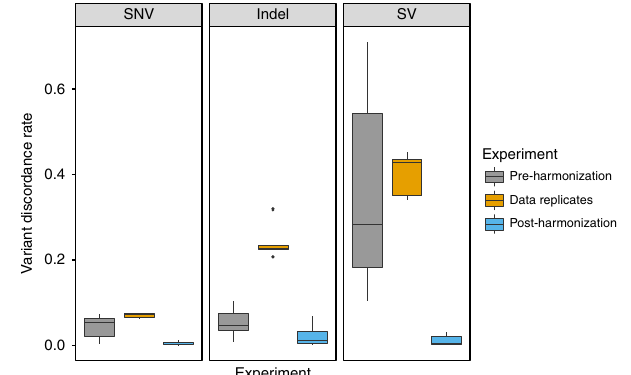
Fig. 2 Pairwise variant discordance rates were calculated between pipelines from each of fi ve centers (pre-harmonization and post-harmonization) as well as between independent sequencing replicates of the same individuals processed by the same pipeline (data replicates). From left, single nucleotide (SNV) and small insertion/deletion (indel) variants were detected with GATK, and structural variants (SV) with LUMPY. The pre- harmonization and post-harmonization comparisons include 14 independently sequenced samples. The data replicate comparisons include four replicates of NA12878 and two replicates of NA19238. Note that the extremely high levels of discordance for SVs pre-harmonization are largely due to variable use of decoy sequences in the reference genomes used by the different centers. The center line is the median, the upper and lower hinges are the fi rst and third quartiles, and the whiskers extend to the largest/smallest values no further than 1.5 * inter-quartile range from the